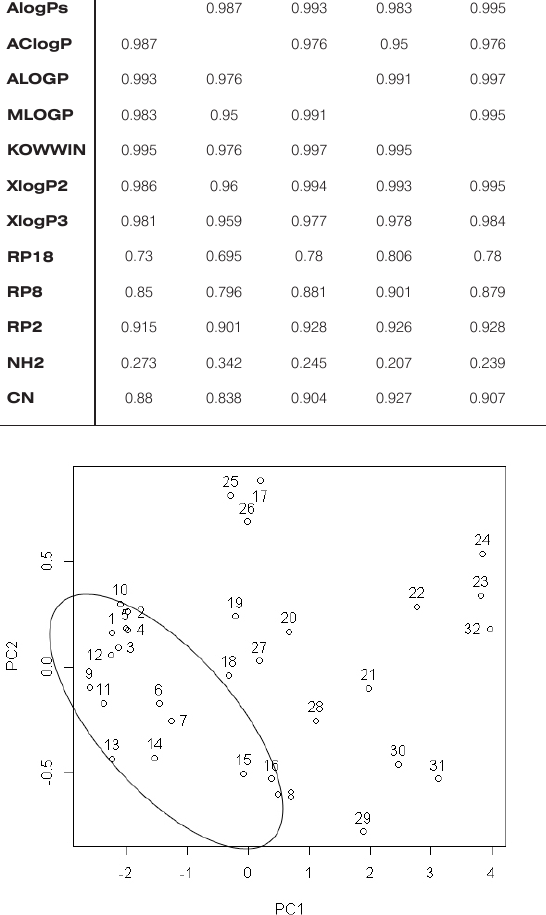
Figure 2. Comparison of lipophilicity of the investigated compounds (experimental log P values) by PCA.